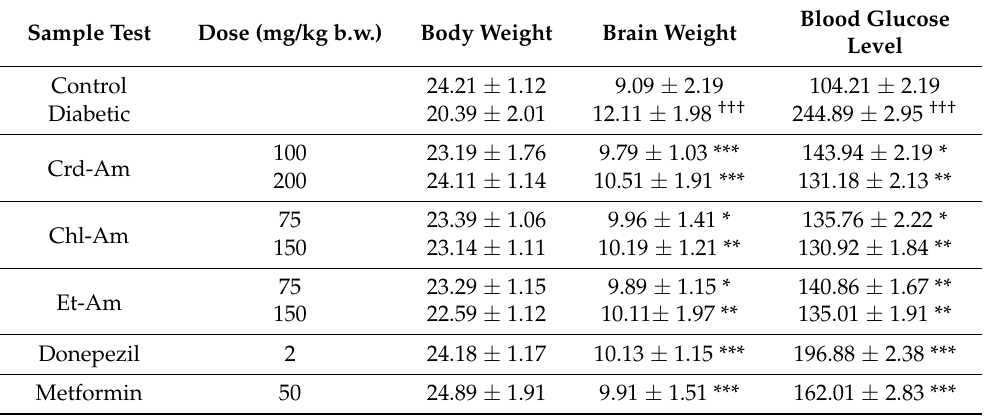
Table 4. Effects of crude extract and fractions of A. macrocephala on blood glucose level, brain and body weight of mice.